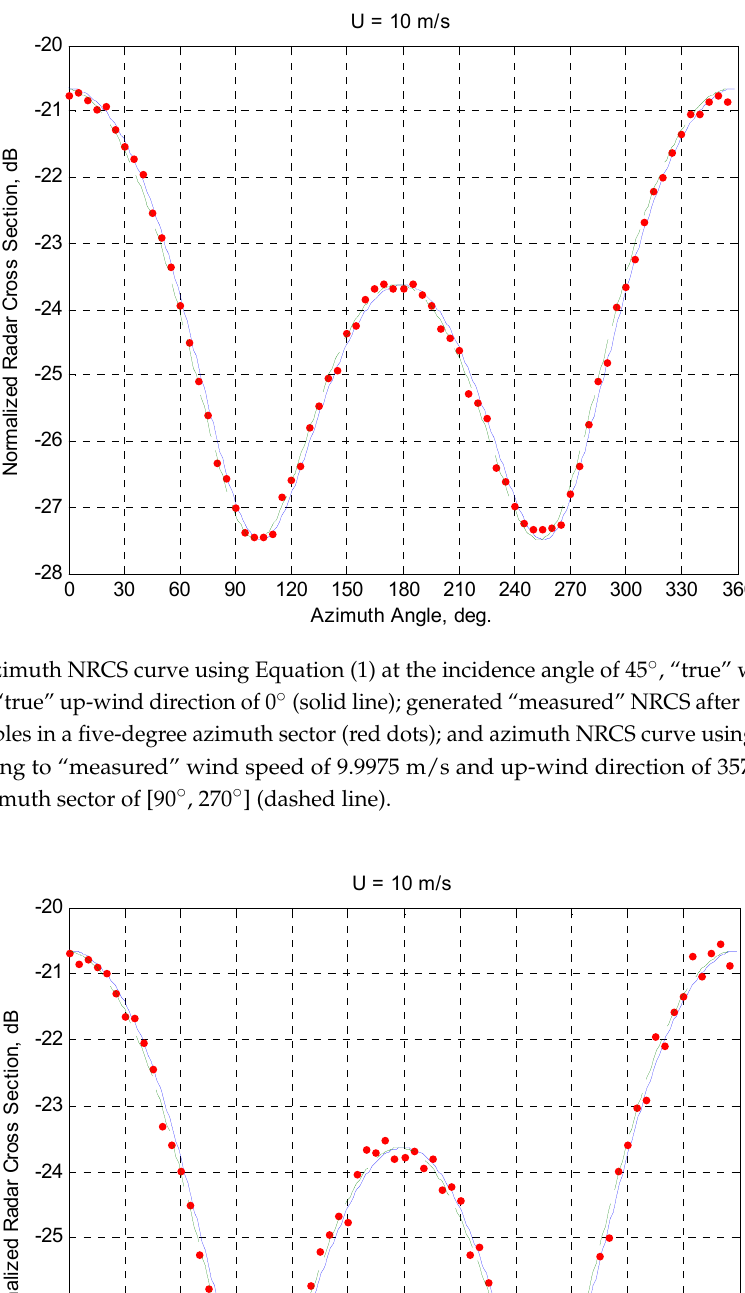
Figure 3. Azimuth NRCS curve using Equation (1) at the incidence angle of 45°, “true” wind speed of 10 m/s and “true” up-wind direction of 0° (solid line); generated “measured” NRCS after the averaging of 1565 samples in a five-degree azimuth sector (red dots); and azimuth NRCS curve using Equation (1) corresponding to “measured” wind speed of 10.0071 m/s and up-wind direction of 357.9° retrieved from the azimuth sector of [45°, 225°] (dashed line).